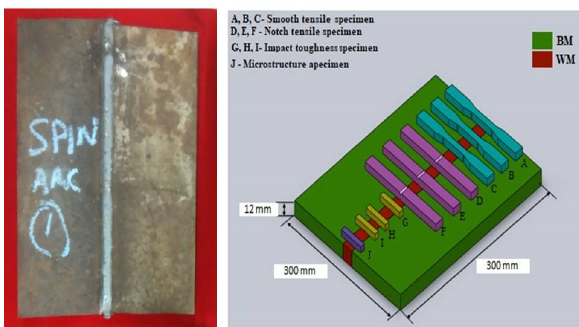
Table 3: Optimized welding parameters used to fabricate the joint.